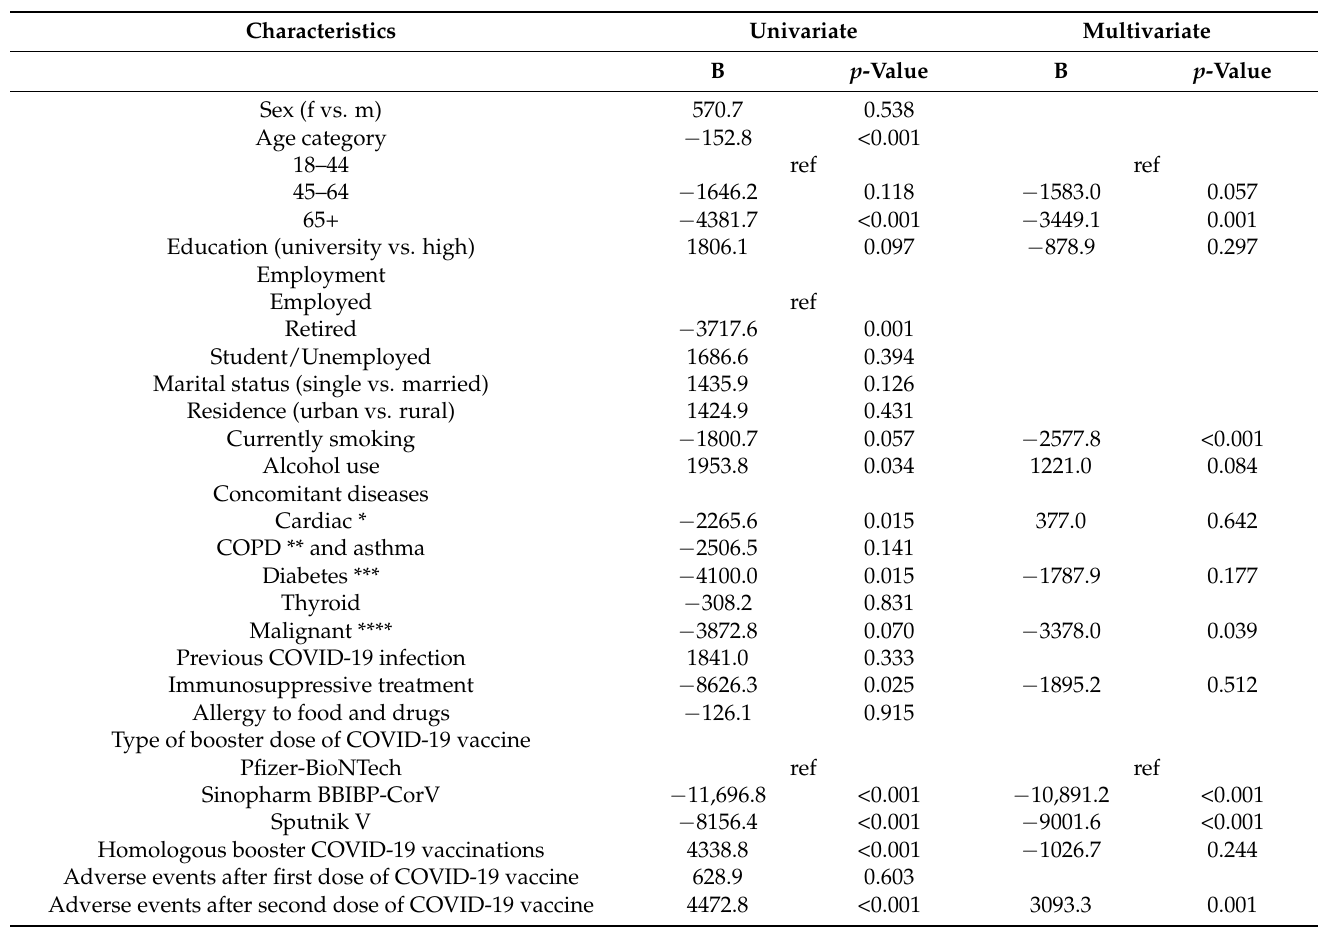
Table 4. Univariate and multivariable linear mixed-effect regression models with IgG values as a dependent variable.